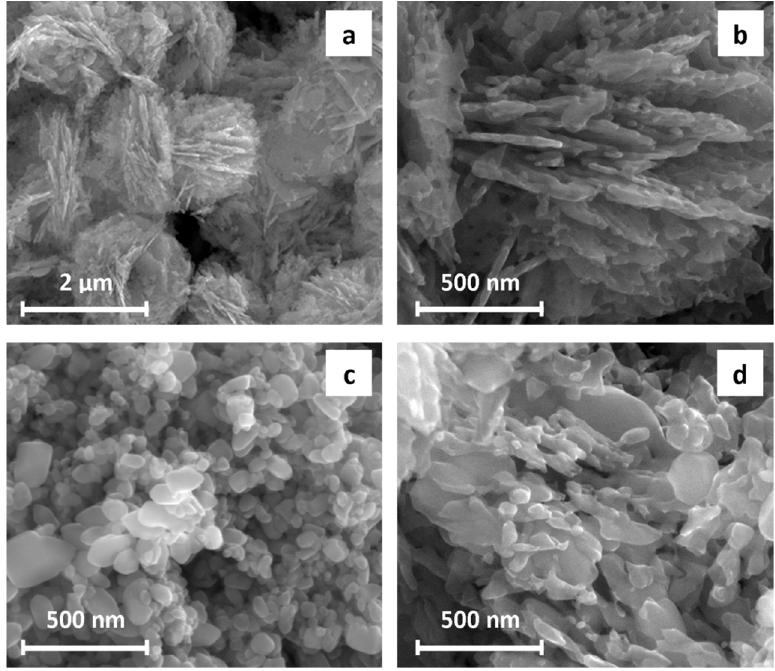
Figure 4. SEM micrographs of ZnO powders A type ( a , b ), B type ( c ) and intermediate forms ( d ).